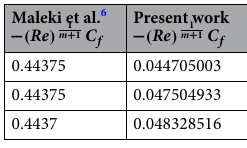
0.7, Ec 0, ϕ 1 0, ϕ 2 0, ϕ 2 . = = = =